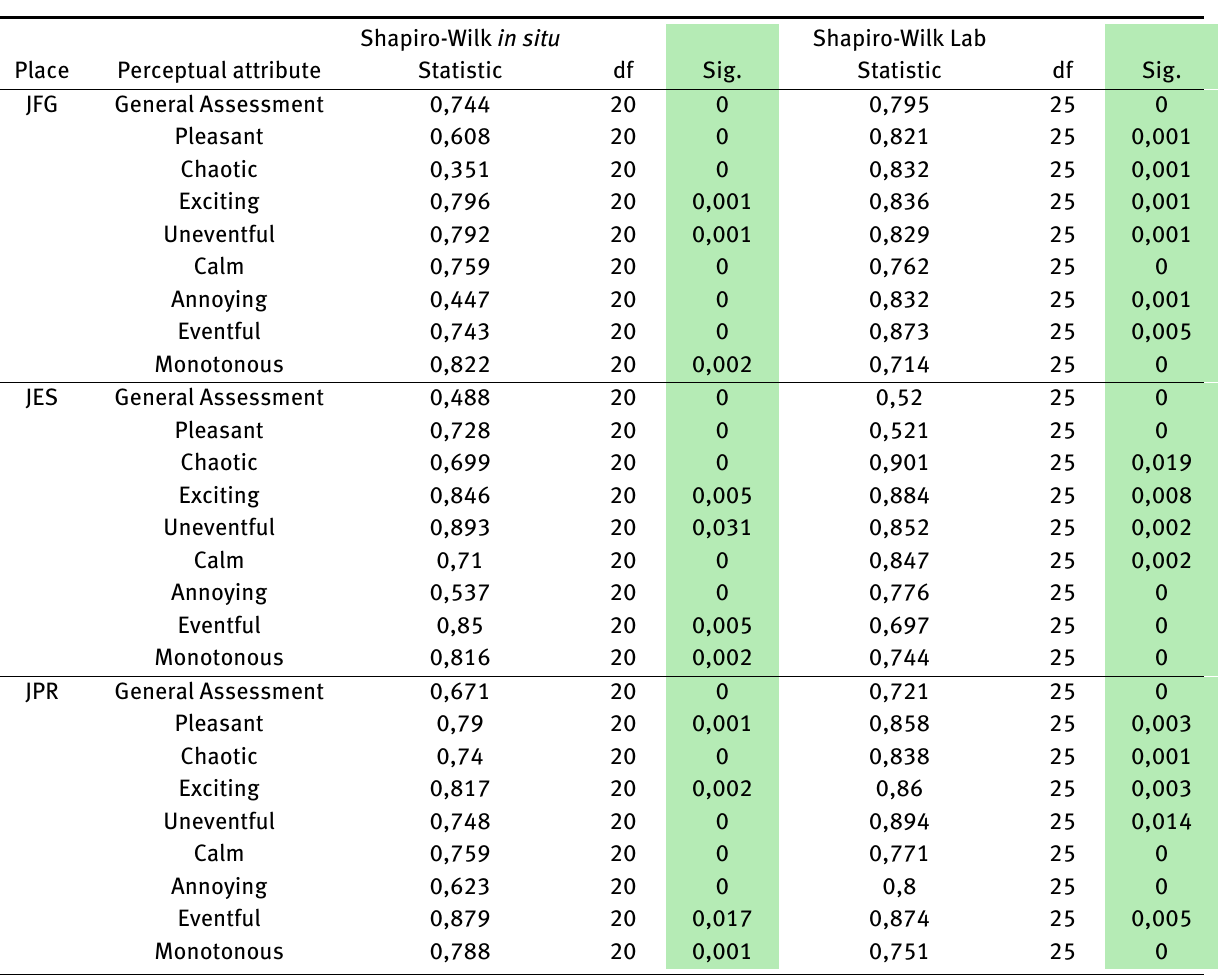
Table 3: Normality Shapiro-Wilk test.